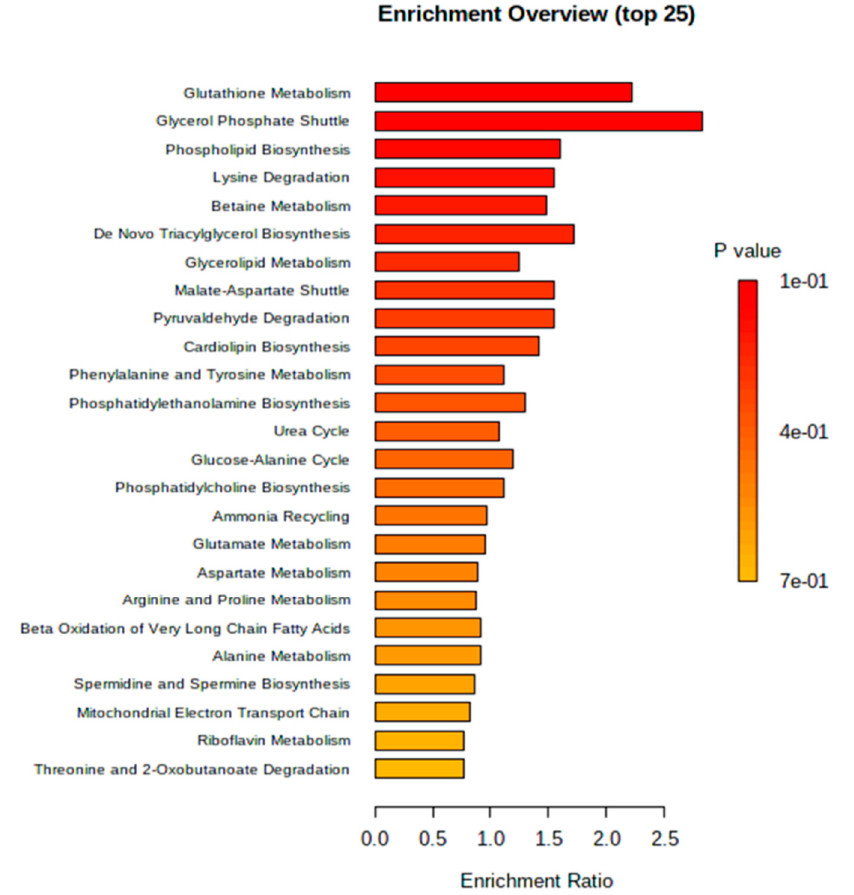
Figure 8. Enrichment analysis of N-limited condition [5% glucose, 0.12% (NH 4 ) 2 SO 4 ] metabolites classified in global path- ways using p value and enrichment pathways. Carbon metabolism, de-novo fatty acid pathway and glutamate linked pathways showed increased p value with a significant increase in their fold change in the N-limited condition metabolite